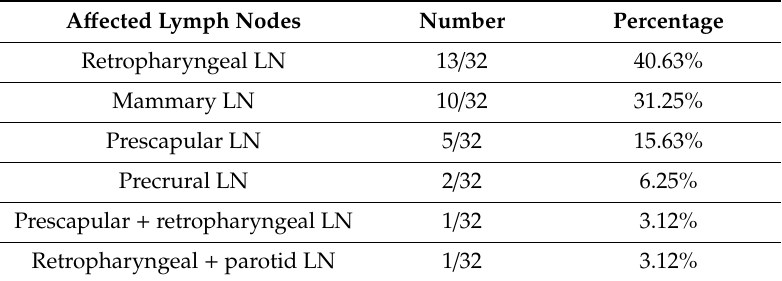
Table 2. Number and percentage of the a ff ected superficial lymph nodes (LN).